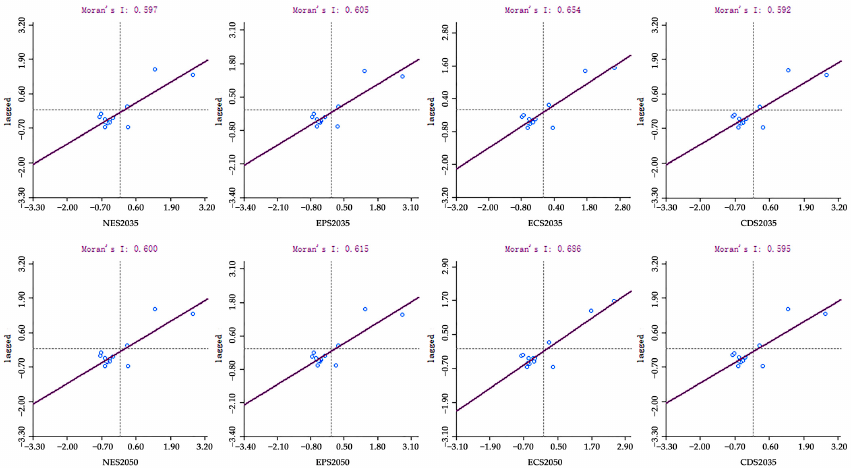
Figure 14. The global spatial autocorrelation analysis of carbon storage in 2035 and 2050 under four scenarios. To reveal the local spatial clustering pattern of carbon storage, the local spatial auto- correlation analysis at the district and county scales in the BTH region in 2035 and 2050 was conducted with the local Moran’s I index. The results are presented in Figure 15, which indicate that the carbon storage under the four scenarios exhibited a certain degree of similarity in spatial distribution. The high-value carbon storage areas were found to exhibit high–high clustering in Huairou District in Beijing, most counties of Chengde City, and Weixian County in Zhangjiakou City, located in the west. In the southwestern areas, Jingfu in Shijiazhuang City, Xingtai in most of Xingtai City, and Binhai New Area in Tian- jin City in the east were found to exhibit high–low clustering. This is primarily due to the fact that these areas are mostly located in the Yanshan and Taihang Mountain ranges,